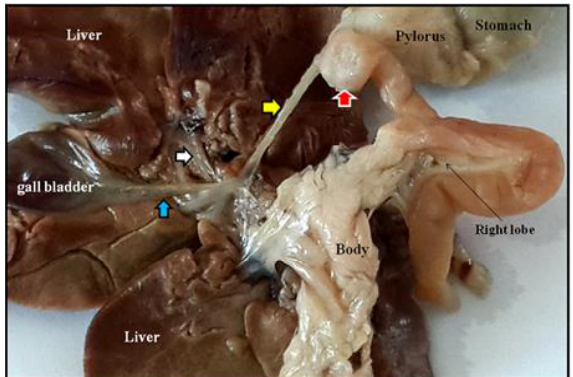
Figure 8. Union of cystic duct (blue arrow) with common hepatic duct (white arrow) to form common bile duct (yellow arrow), pass through 1st duodenal flexure (red arrow).